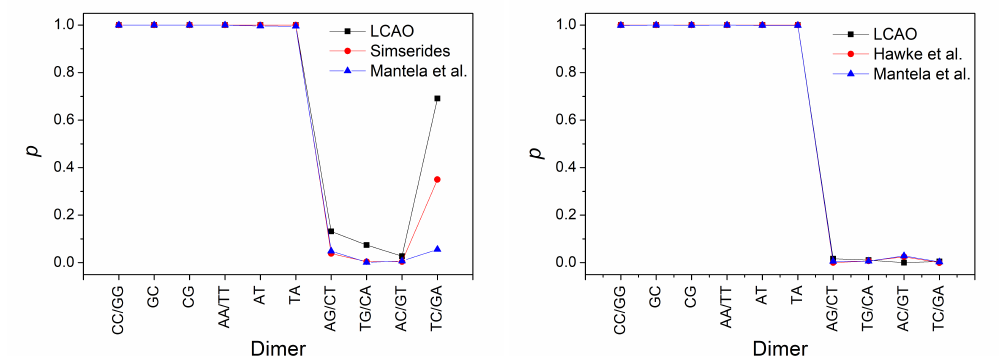
Figure 9. Comparison of the maximum transfer percentage p obtained by our LCAO method using all valence orbitals, with the p values extracted from other sources: obtained from parameters found in Reference [55] (for holes, estimation from various articles in bibliography), in Reference [29] (using only 2p z orbitals) and in Reference [52] (for electrons, using only 2p z orbitals). Left panel for holes, right panel for electrons.